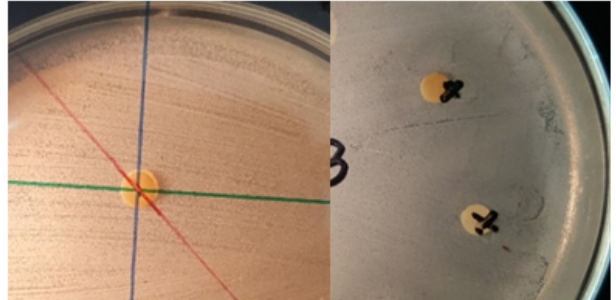
Figure 3. Measurement of growth inhibition zone diameter. Left panel, measurement guidance; right panel, growth inhibition zone of S. mutans.